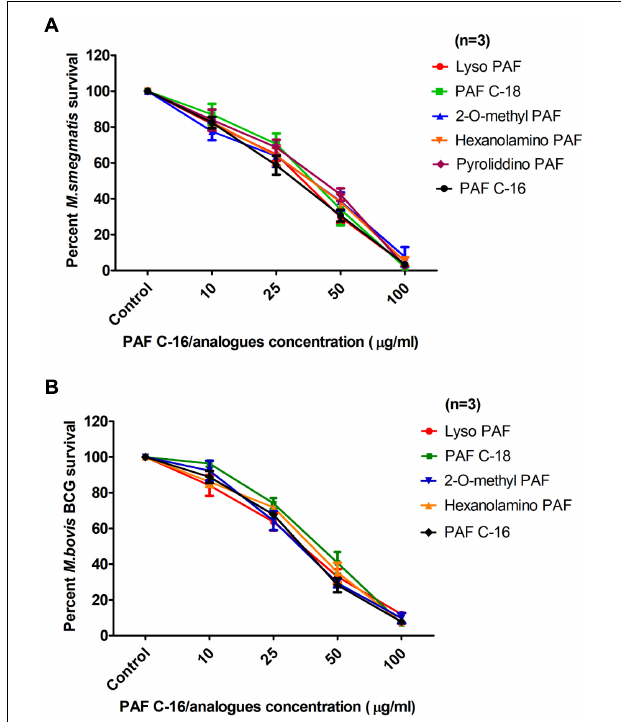
FIGURE 4 | Comparison of the levels of growth inhibition by different PAF C-16 analogs and PAF C-16 for M. smegmatis and M. bovis BCG. Number of surviving colony forming units of M. smegmatis (A) and M. bovis BCG (B) after 2 h treatment with indicated concentrations of different PAF C-16 analogs and PAF C-16. The data is expressed as percentage survival where solvent control is taken as 100% survival. Each data point represents the average of three individual experiments performed in triplicate and the error bars show the standard error of mean values ( ±